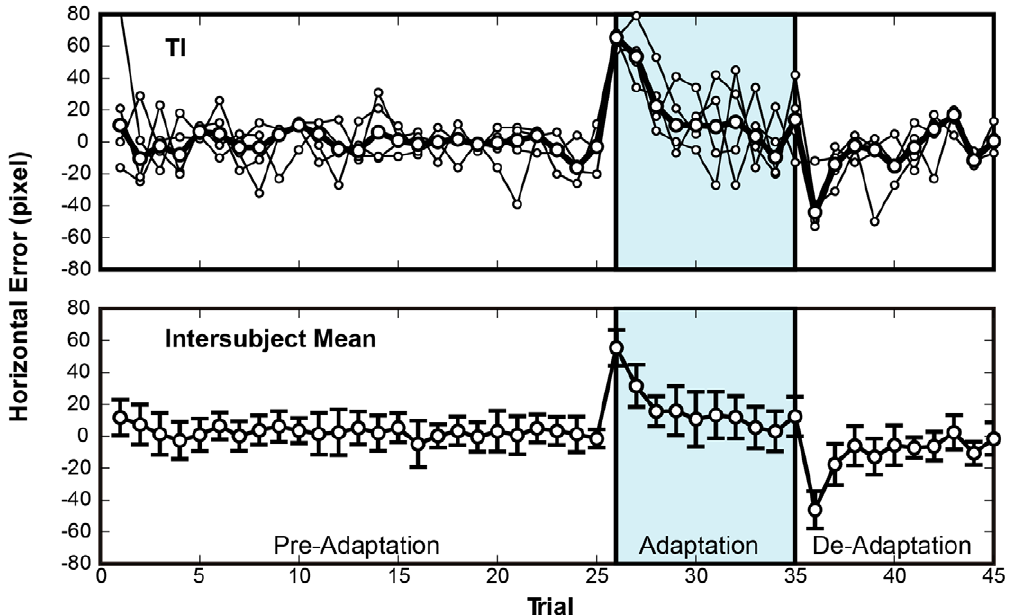
Figure 2. Adaptation curve from Experiment 1, 0-ms condition. The horizontal error is plotted against the sequence of trials. The upper and lower panels show the data for one typical subject (TI) and the average for all subjects, respectively. In the upper panel, the thin lines represent the results for four individual sessions and the bold line represents their median. Although inter-session variability was rather large, the median shows a typical adaptation curve. In the lower panel, the bold line shows the averages for all subjects, and the error bars show the standard deviation. The averaged learning curve is a classic adaptation curve.